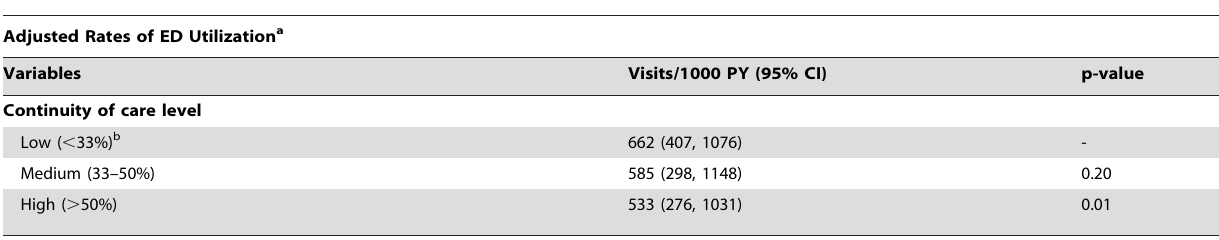
Table 4. Association Between Levels of Continuity of Care and Emergency Department Utilization for Patients with $ 1 Continuity